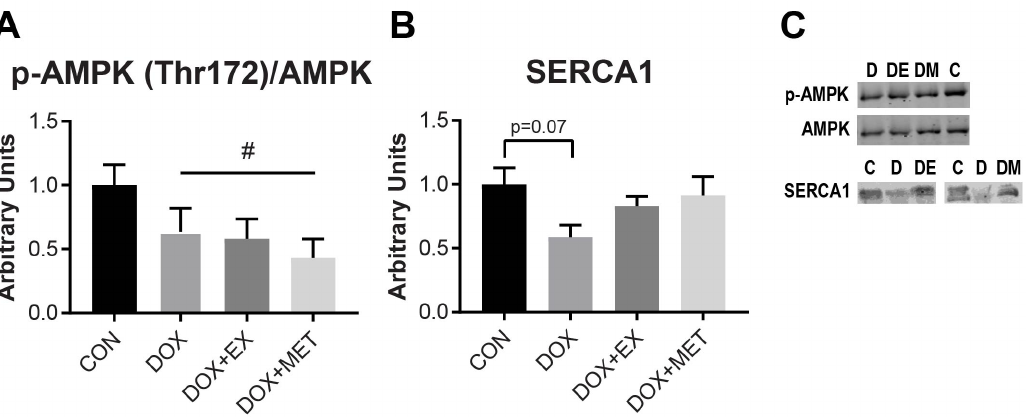
Figure 4. AMPK phosphorylation and SERCA1 protein expression measured in gastrocnemius muscle via Western blot. ( A ) AMPK phosphorylation (Thr172) ( n = 5). ( B ) SERCA1 protein expression ( n = 5). ( C ) Representative Western blots. Main effect of DOX ( p < 0.05) is indicated by